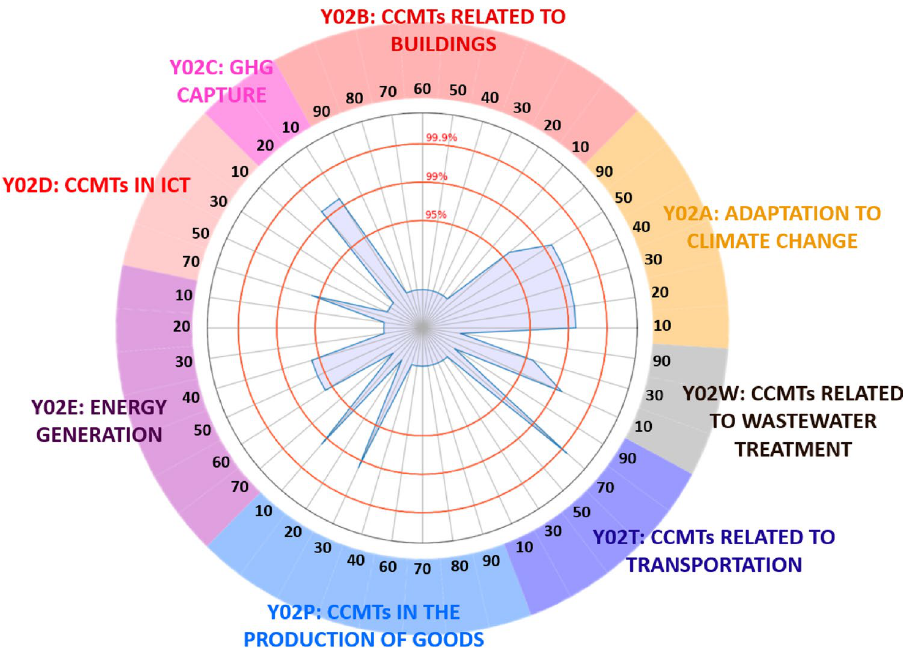
Table 2. Exported product sections. 1